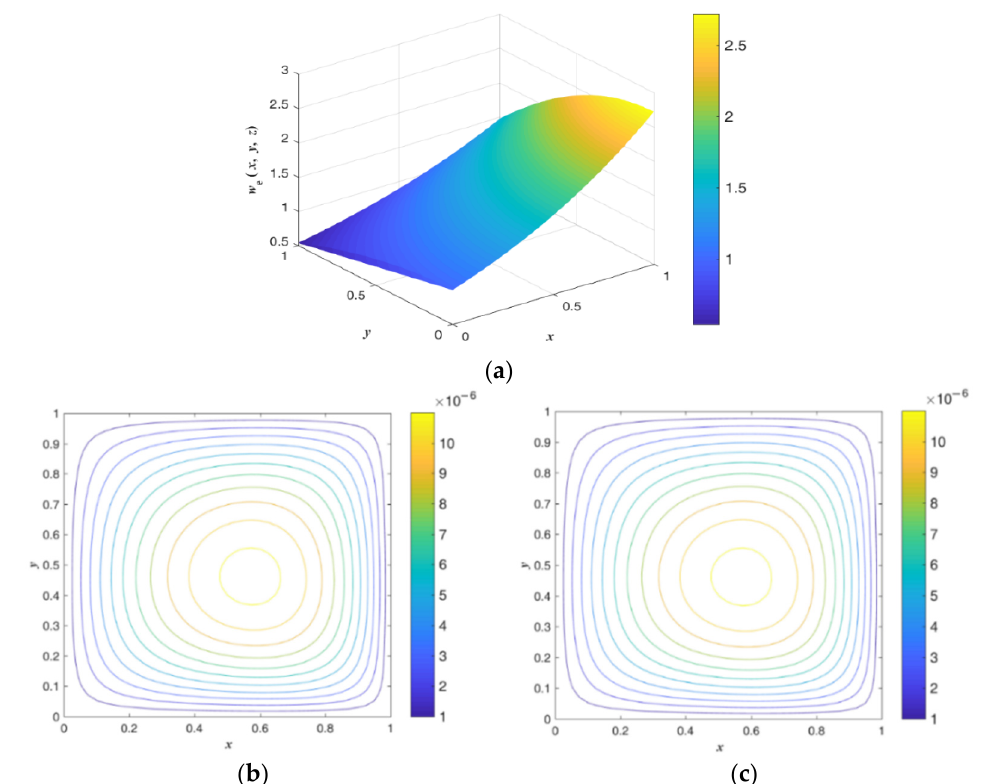
Figure 3. Potential distributions for a linear problem: ( a ) exact solution; ( b ) absolute errors of EM; ( c ) absolute errors of RK4.